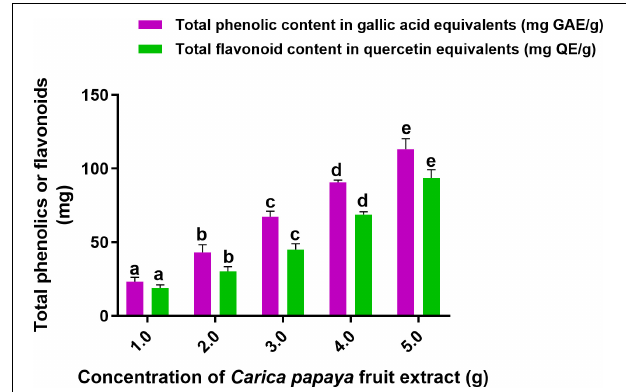
FIGURE 1 | Total content of phenolics and flavonoids in C. papaya fruit extract. The experiments in the study were carried out three times, each time independently. The mean and SD of the triplicate research were calculated using the results from each experiment. The bar graphs with different letters within the particular analysis were significant ( p -value ≤ 0.05) by Tukey’s